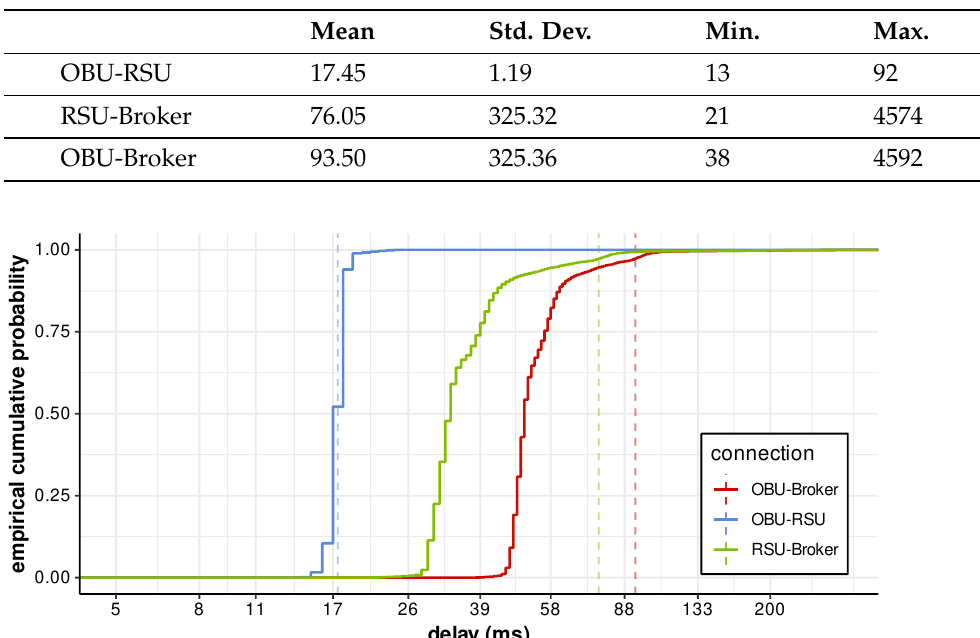
Table 3. OBU (Facilities layer) to RSU (Facilities layer) to cloud broker (listening client) delay results in milliseconds for the RSU with an LTE connection to the Internet.